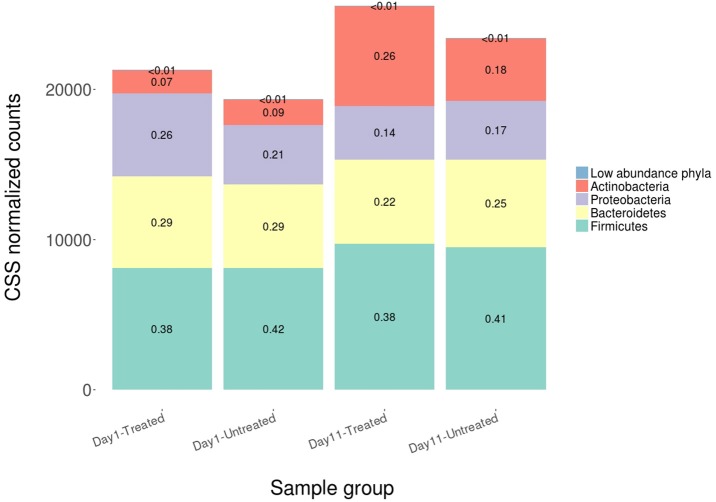
Average relative abundance of CSS normalized counts of shotgun metagenomic reads aligning to bacterial, archaeal and viral genomes at the phylum level for both study groups at Day 1 and Day 11. Phyla comprising <3% of each sample group were combined into the category “Low abundance phyla”.